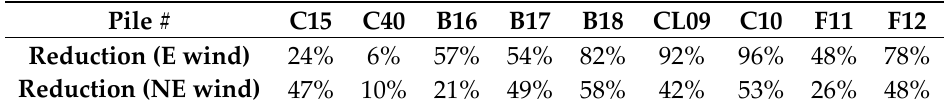
Figure 4. Ratios of surface wind speed to approach wind speed. Initial situation. Table 1. Particles emission